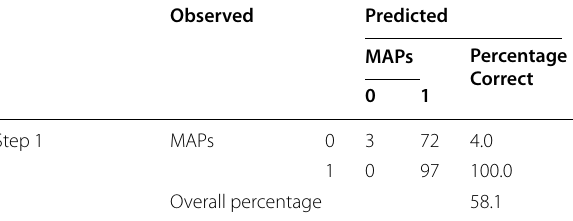
Table K: Classification table for people orientation culture